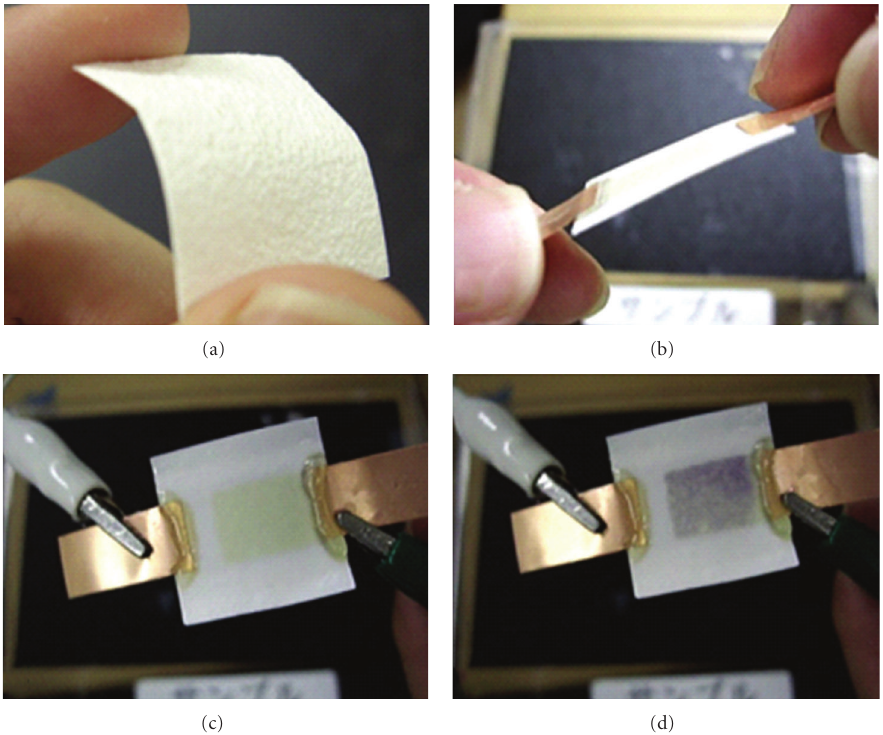
Figure 19: (a) The paper made of nanocellulose; (b) display device; (c) and (d) show the result of the chromogenic testing [189].